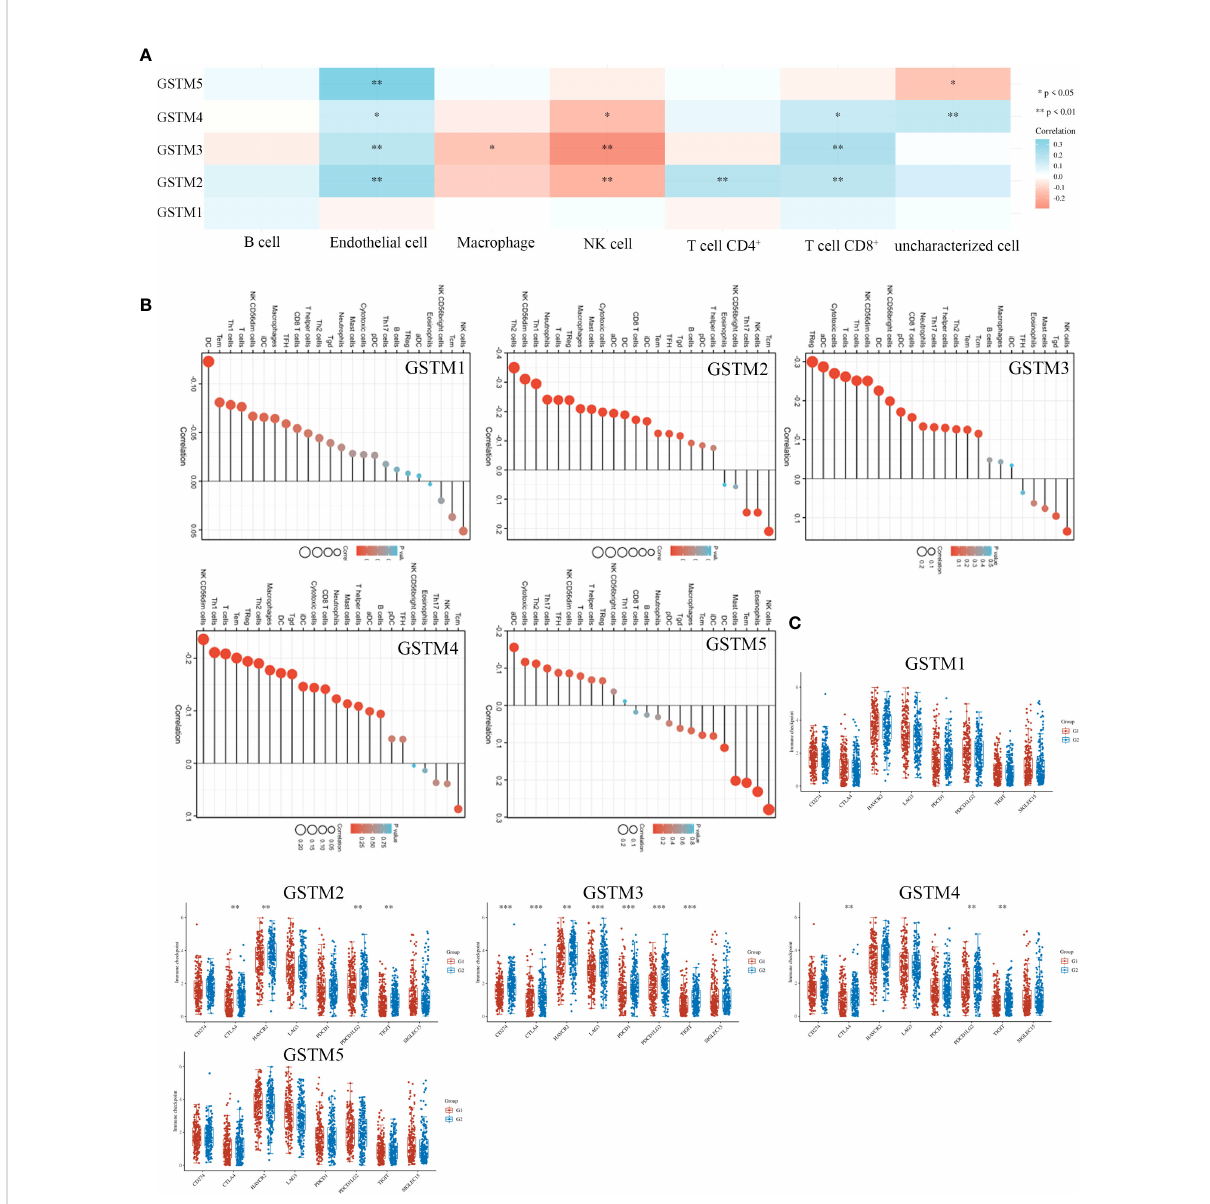
FIGURE 7 The correlation of immune in fi ltration and GSTMs expression in OC. (A) The expression pro fi les of GSTM1, GSTM2, GSTM3, GSTM4 and GSTM5 in multiple immune cell types based on TCGA database. (B) The effect of GSTMs on the components of cellular immunity. (C) The correlation analysis between GSTMs expression and immune checkpoints gene expression in TCGA database via the Wilcox test. (G1 is the group of the OC patients with high expression of GSTMs. G2 is the group of the OC patients with low expression of GSTMs.) *p < 0.05; **p < 0.01; ***p <